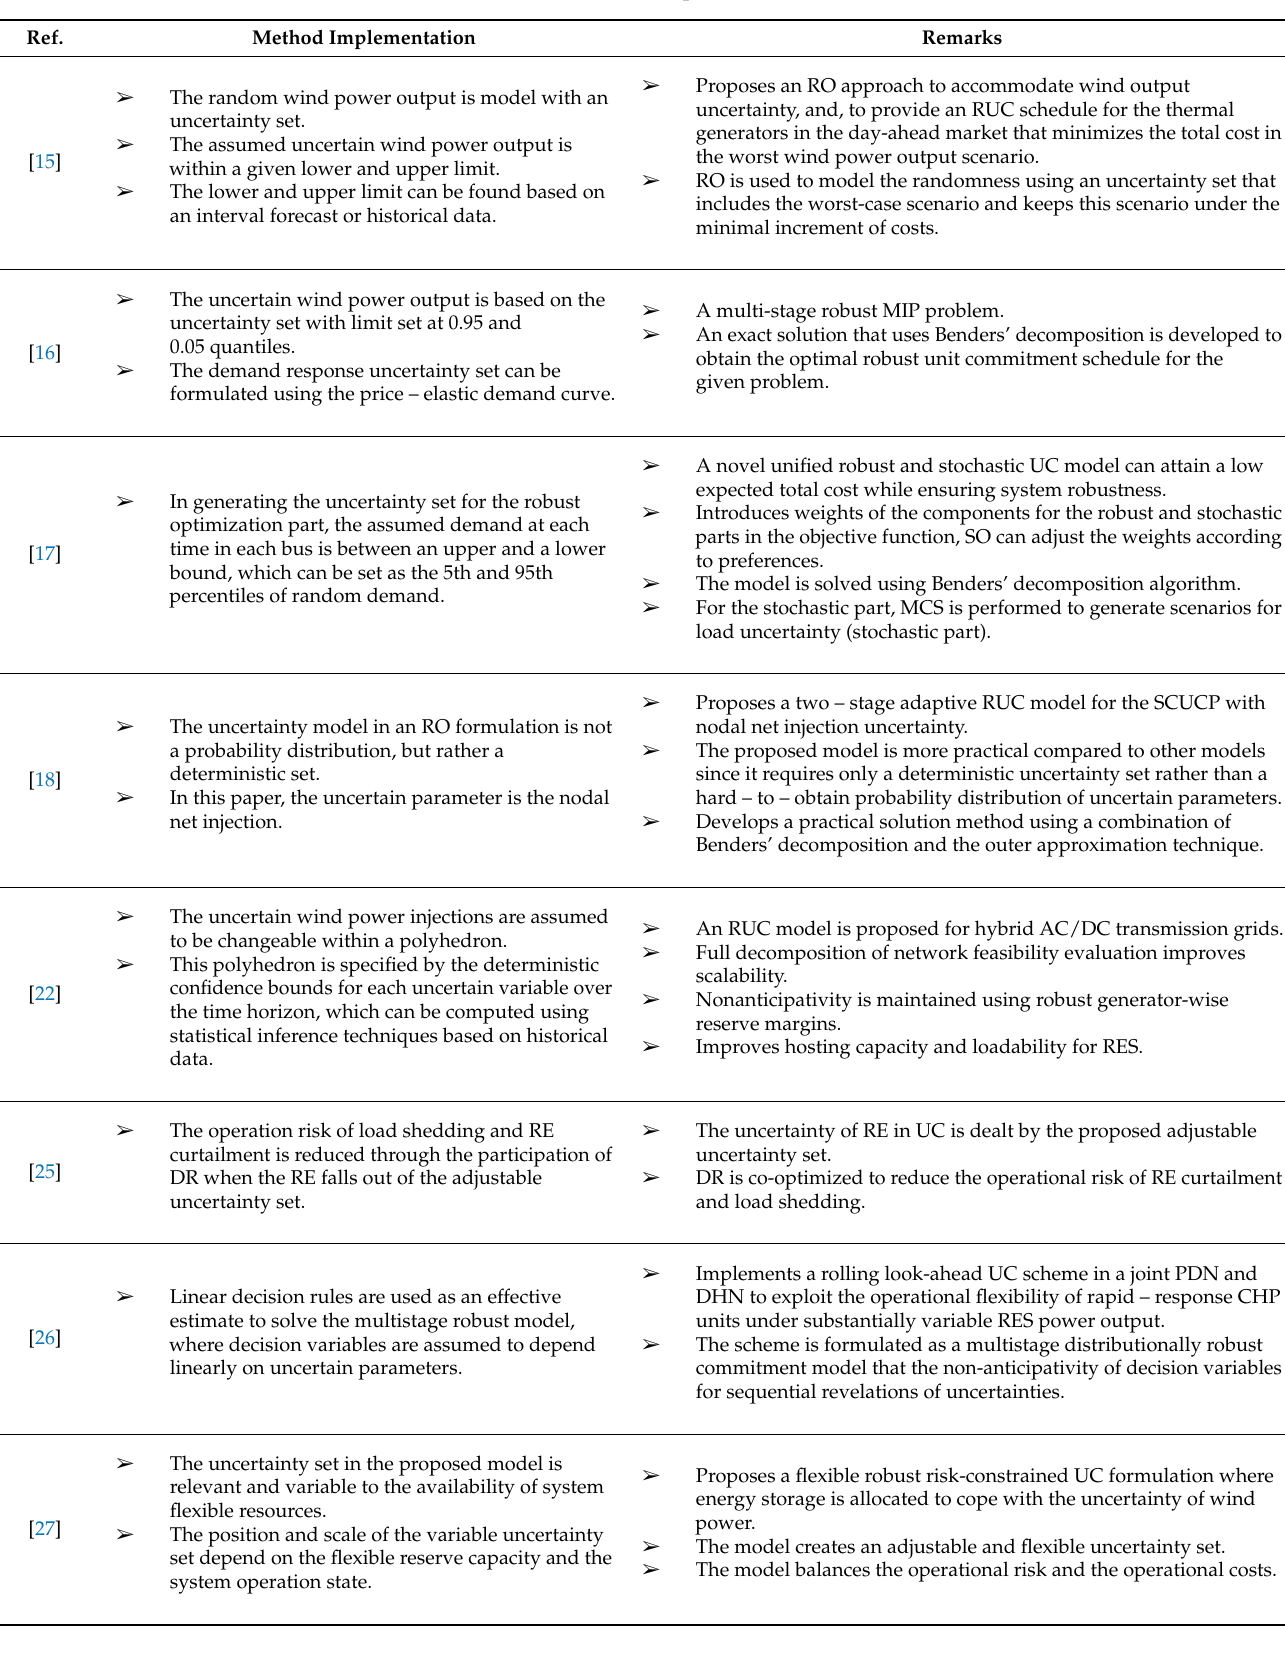
Table 13. Studies In Which Robust Optimization Method Is